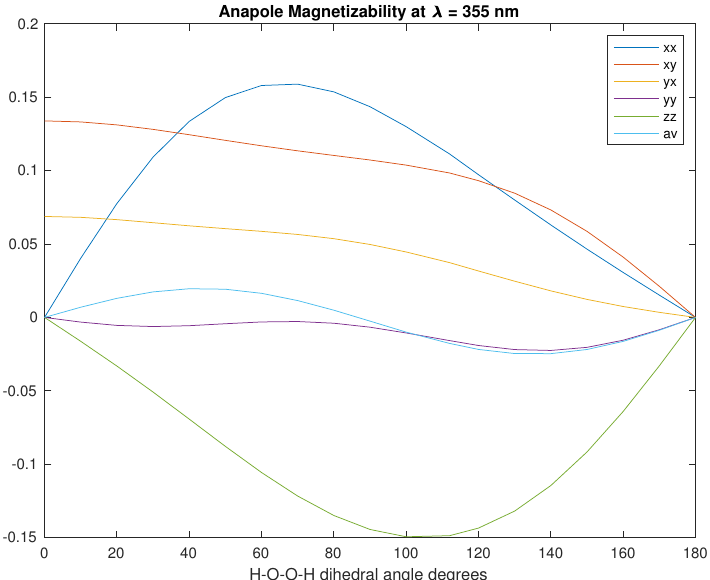
Figure 3. Tensor components of anapole polarizability f (cid:48) peroxide molecule at λ = 589.3 nm, as a function of the dihedral angle.